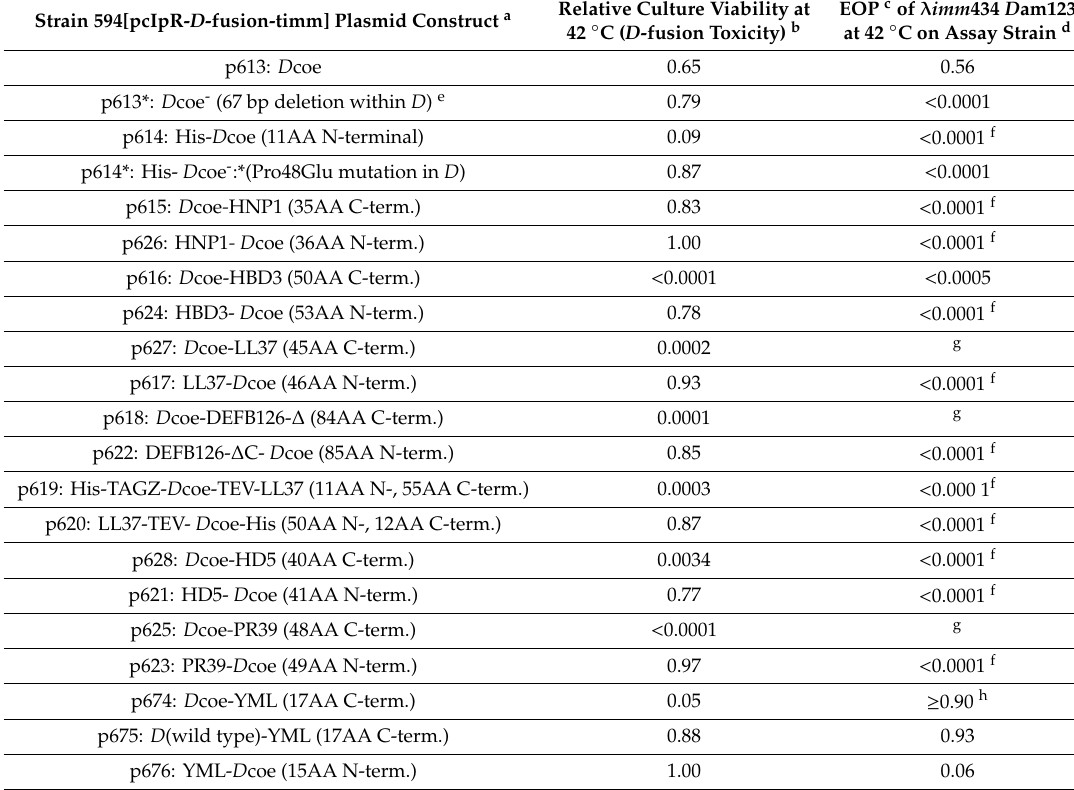
Table 3. Assessing if Antimicrobial peptides (AMPs) fused to gpD can complement for lambda infectivity and if the expression of the construct is toxic to E. coli cells. Relative Culture Viability at Strain 594[pcIpR- D -fusion-timm] Plasmid Construct a 42 ◦ C ( D -fusion Toxicity)